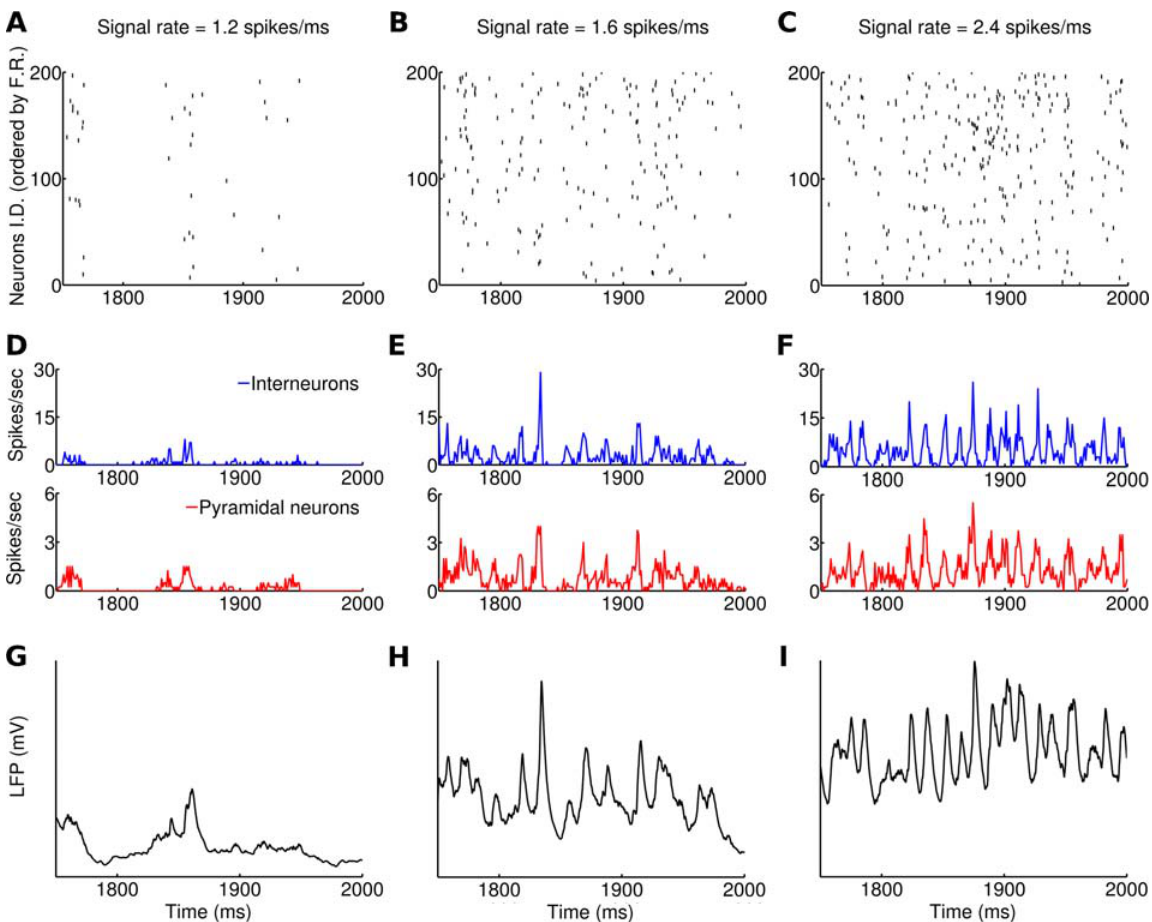
Figure 2. Dynamics of the network receiving a constant signal, with three different rates (left, middle, right column: 1.2, 1.6, 2.4 spikes/ms), superimposed to noise. In each column, all panels show the same 250 ms interval (extracted from a 2 seconds simulation). (A–C) Raster plot of the activity of 200 pyramidal neurons (those that had the highest firing rate during the simulation). (D–F) Average instantaneous firing rate (computed on a 1 ms bin) of interneurons (blue, upper panels) and pyramidal neurons (red, lower panels). Notice the difference in scale. (G–I) LFP of the network, modeled as the sum of the absolute values of AMPA and GABA currents on pyramidal neurons (see Methods). Notice that the population oscillations become more pronounced as the rate of the signal increased, while oscillations are not detectable at the single neuron level.